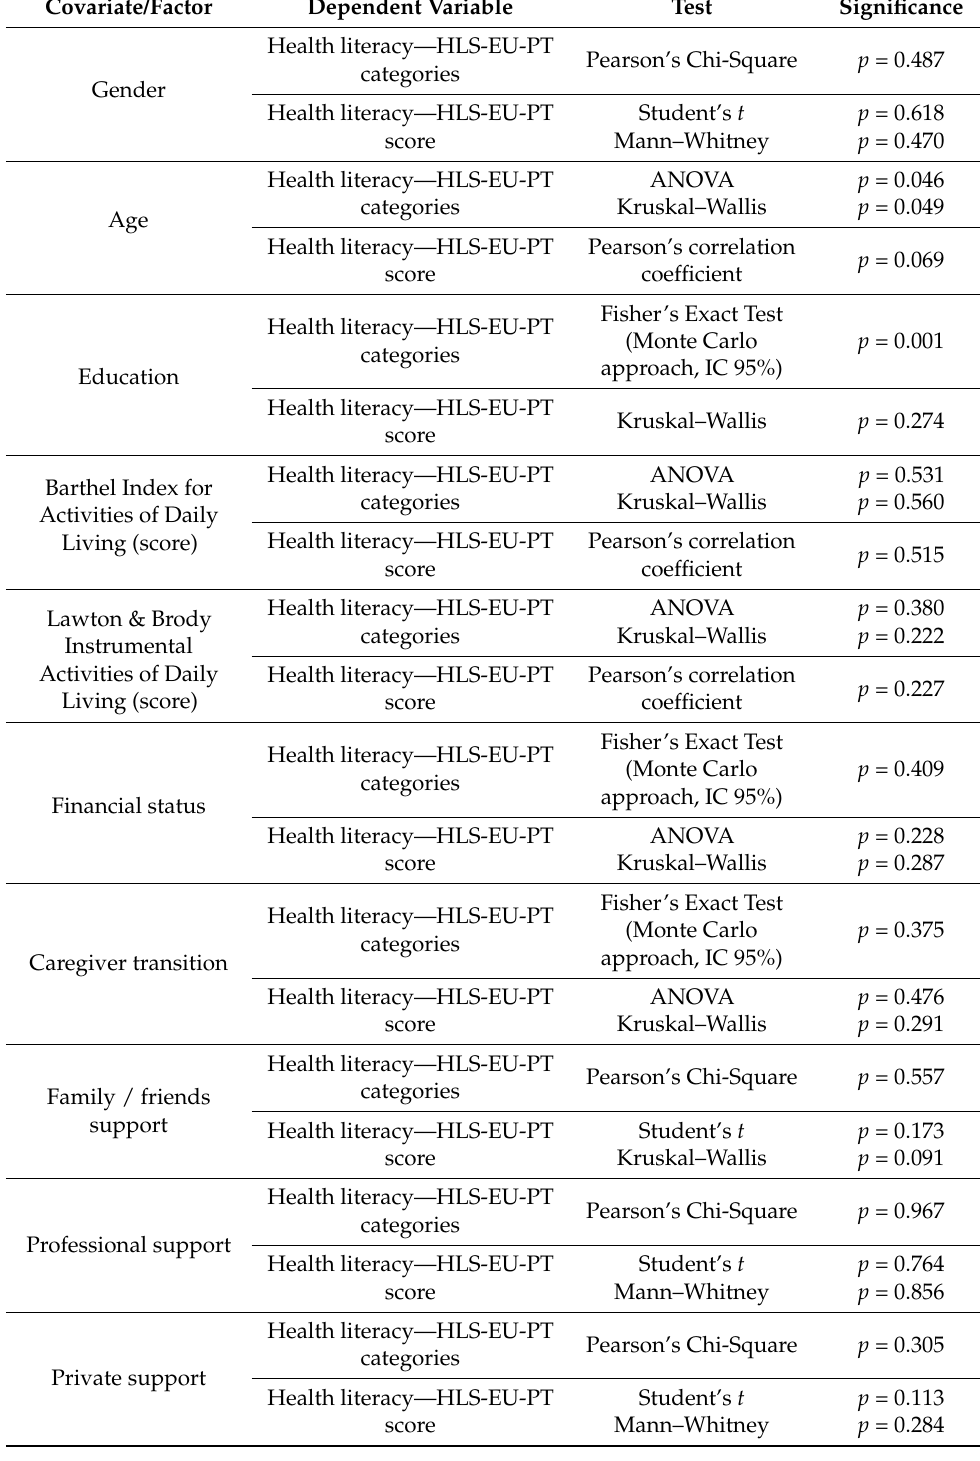
Table A2. Bivariate statistics—health literacy and sociodemographic factors (full